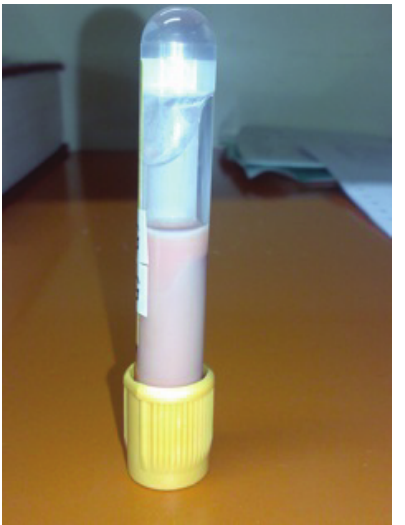
Figure 1: Patient’s hyperlipemic serum.